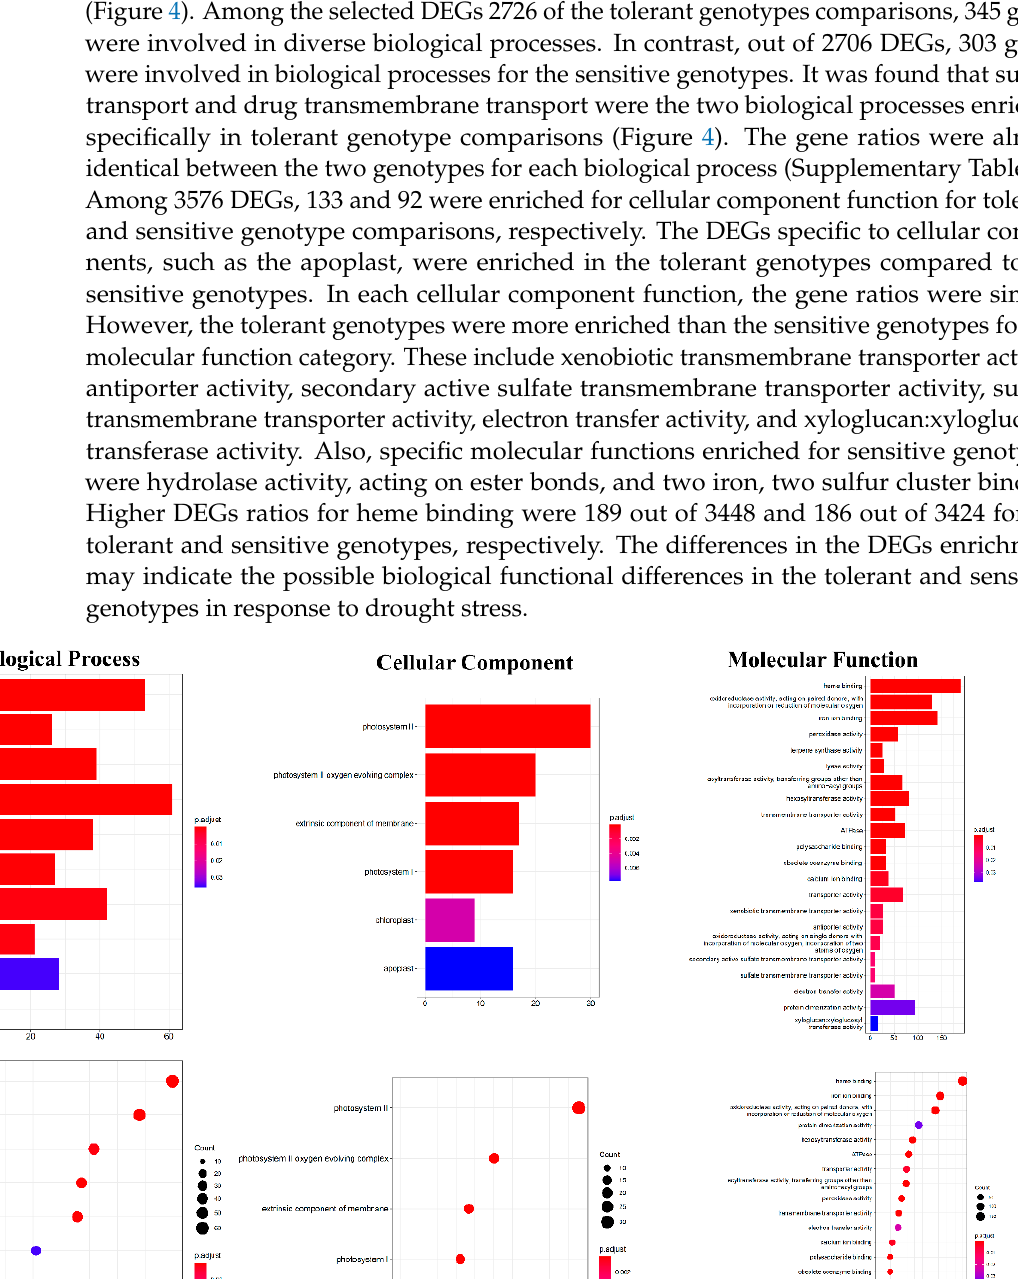
Figure 4. Based on gene ontology (GO) annotation, the root and leaf comparisons of tolerant and sensitive genotypes reveal DEG enrichment for biological processes, cellular components, and mo- lecular functions. Gene ratios for enriched DEGs are included. The number of genes involved are plotted against each GO terms (Biological process, cellular components, molecular function). The DEGs were annotated against the GO database. The GO enrichment was based on the padj < 0.05.